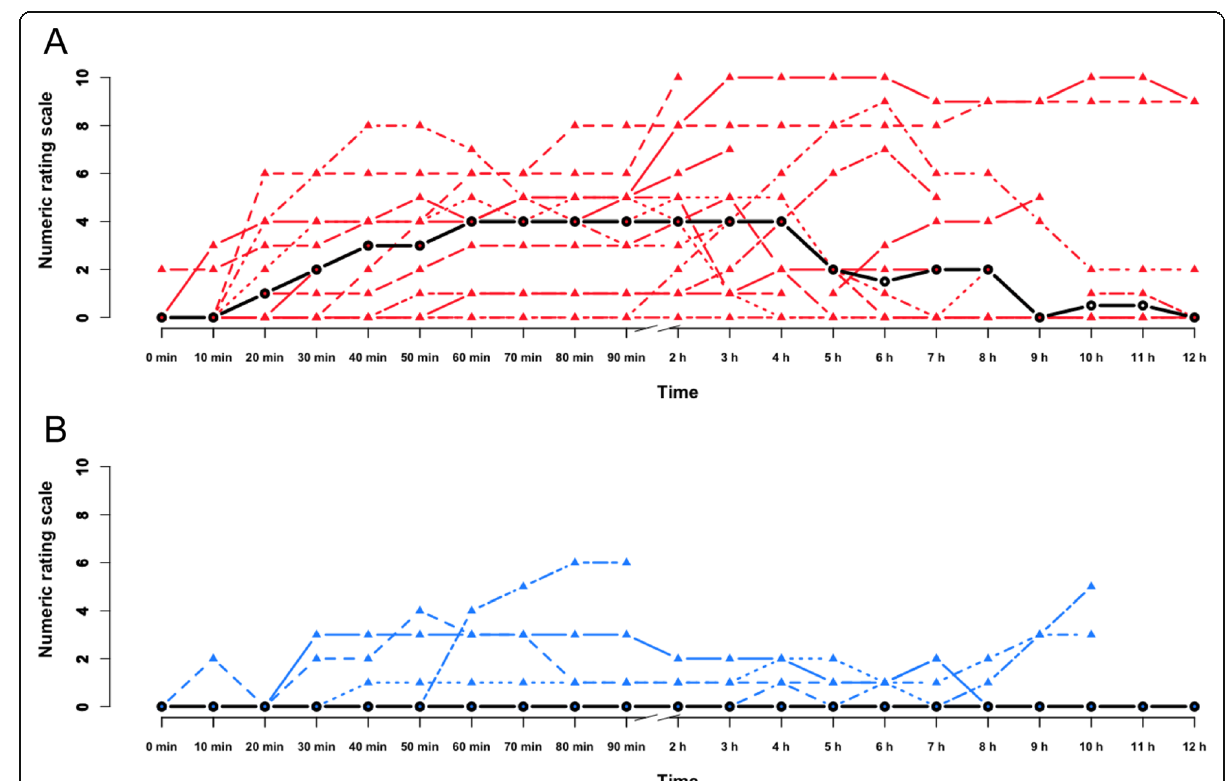
Fig. 5 Headache intensity after CGRP and placebo. Individual headache intensity scores on the CGRP day ( a ) and placebo day ( b ). Black lines: Median intensity at each time point. The median headache intensity was 0 for all time points after placebo. The median time (range) to onset of migraine was 50 min (20 – 152.5) after